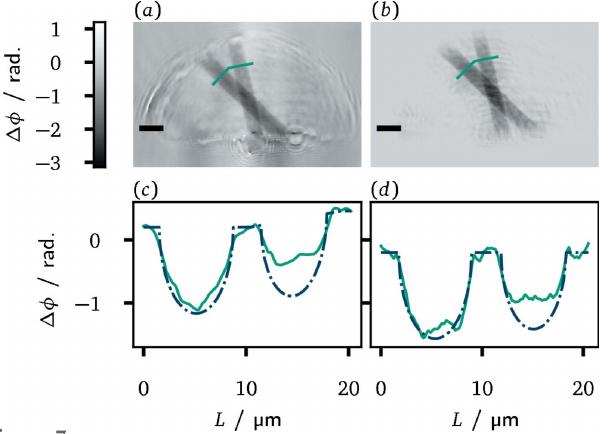
Figure 7 Phase reconstructions of the crossed carbon fibre sample via grating interferometry in a projection microscope ( a ) with m T = 11/16 and via PBPCI ( b ). The scale bar indicates 10 m m length in both panels. Panels ( c ) and ( d ) show section profiles along the line segments indicated in ( a ) and ( b ), respectively (green curves). The expected profile for carbon fibres with a diameter of 7.2 m m and 6.4 m m is shown for comparison (blue dash- dotted curve). Note, that the expected profile plot was adjusted to the baseline of the